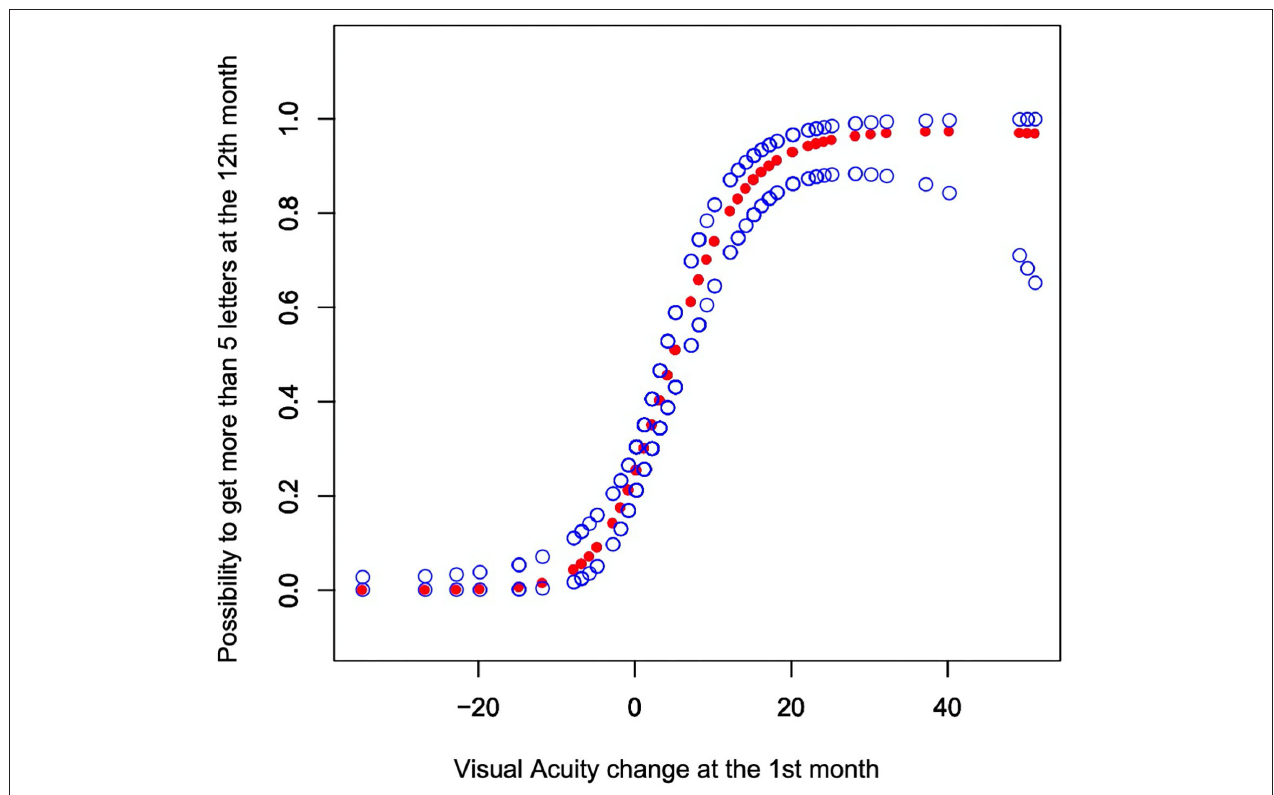
FIGURE 2 | The y-axis shows the possibility to get more than 5 letters at the 12th month with the 95% CI. The model was adjusted by sex, age, smoking status, hypertension, diabetes, PCV or CNV, history of wet AMD, PDT (photodynamic therapy), treatment groups, number of injections, diameter of lesions, and baseline